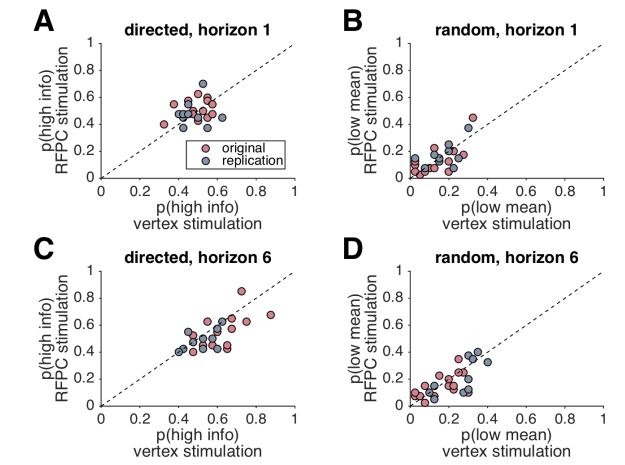
No difference in effects between original and replication experiments.In each panel we plot the model-free measures of directed and random exploration and how they change between stimulation conditions. For example, in Panel A, we plot p(high info) in horizon 1 for vertex stimulation (x-axis) and RFPC stimulation (y-axis). Each point in this plot is a single subject and the diagonal line represents equality. Participants below the diagonal line have a smaller value of p(high info) in the RFPC stimulation condition. From this we can clearly see that there is no effect of RFPC stimulation on directed exploration in horizon 1 (panel A), or random exploration in either horizon (B, D). However, there is a strong effect of RFPC stimulation on directed exploration in horizon 6 with the majority of points lying below the diagonal (C). Moreover, both the original and replication datasets point to the same conclusions in all four panels.